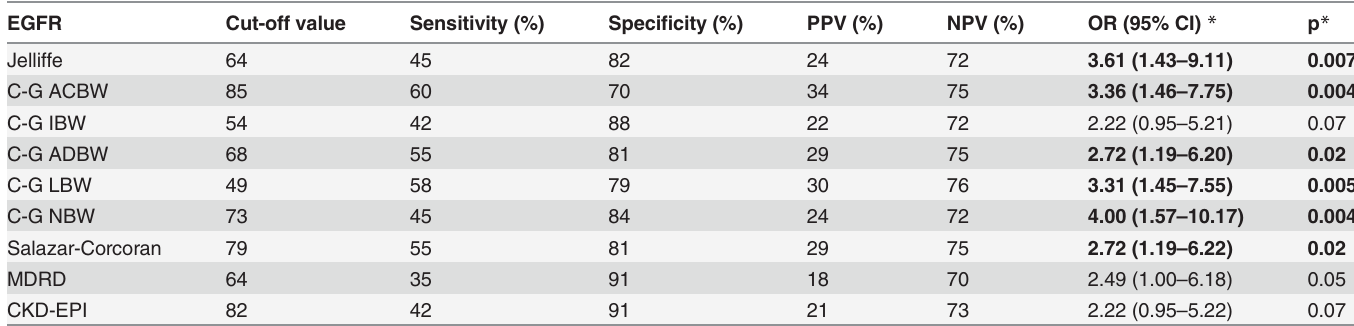
Signi fi cant associations are shown in